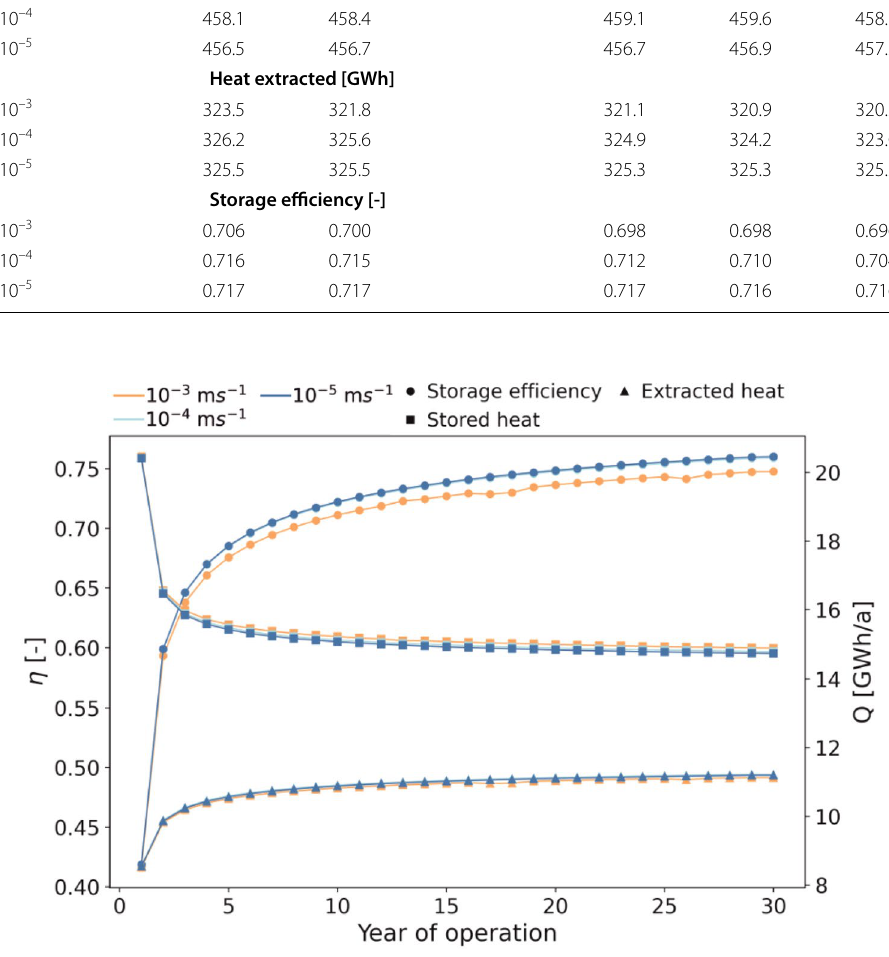
Fig. 10 Storage efficiency, the amount of stored and extracted heat for annual cycles over 30 years of simulation for a fault zone thickness of 0.5